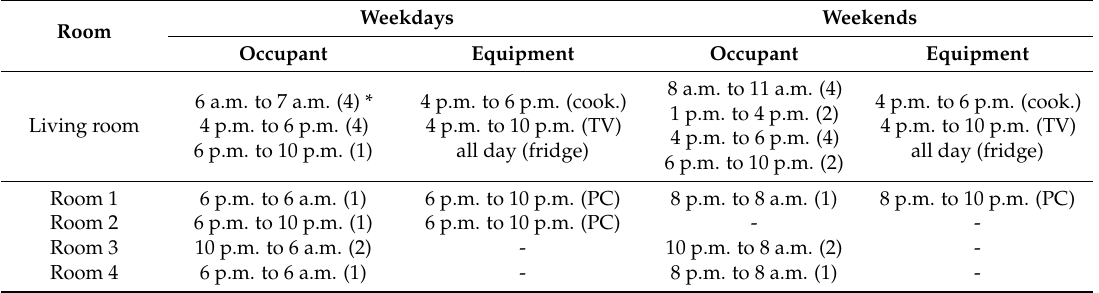
Table 1. Internal heat gains